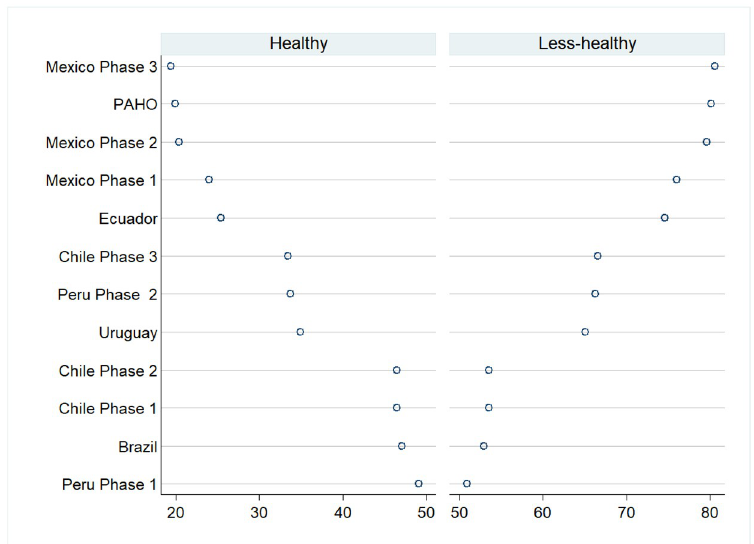
Fig 1. Percentage of products classified as “healthy” and “less healthy” by the PAHO model and Latin American NPs ( n = 36,844 unique packaged products). Products with no warning labels were classified as healthy; products with 1 or more “high in ... ” warnings were classified as less healthy. For the Ecuador NP model, products with 1 or more warnings of moderate (yellow) or high (red) content of nutrients of concern were classified as less healthy. Percent agreement (A) was assessed using kappa coefficients ( k ): 0.01–0.20, slight; 0.21–0.40, fair; 0.41–0.60, moderate; 0.61–0.80, substantial; 0.81–0.99, near perfect. PAHO (reference); Mexico Phase 3 ( k = 0.861; A: 95.6%); Mexico Phase 2 ( k = 0.764; A: 95.3%); Mexico Phase 1 ( k = 0.764; A: 91.9%); Ecuador ( k = 0.764; A: 89.8%); Uruguay ( k = 0.572; A: 82.5%); Chile Phase 3 ( k = 0.557; A: 82.3%); Peru Phase 2 ( k = 0.604; A: 84.2%); Chile Phase 2 ( k = 0.479; A: 77.7%); Chile Phase 1 ( k = 0.372; A: 69.9%); Brazil ( k = 0.431; A: 73%), Peru Phase 1 ( k = 0.379; A: 69.3%). All comparisons were statistically significant ( p < 0.05). NP, nutrient profile; PAHO, Pan American Health